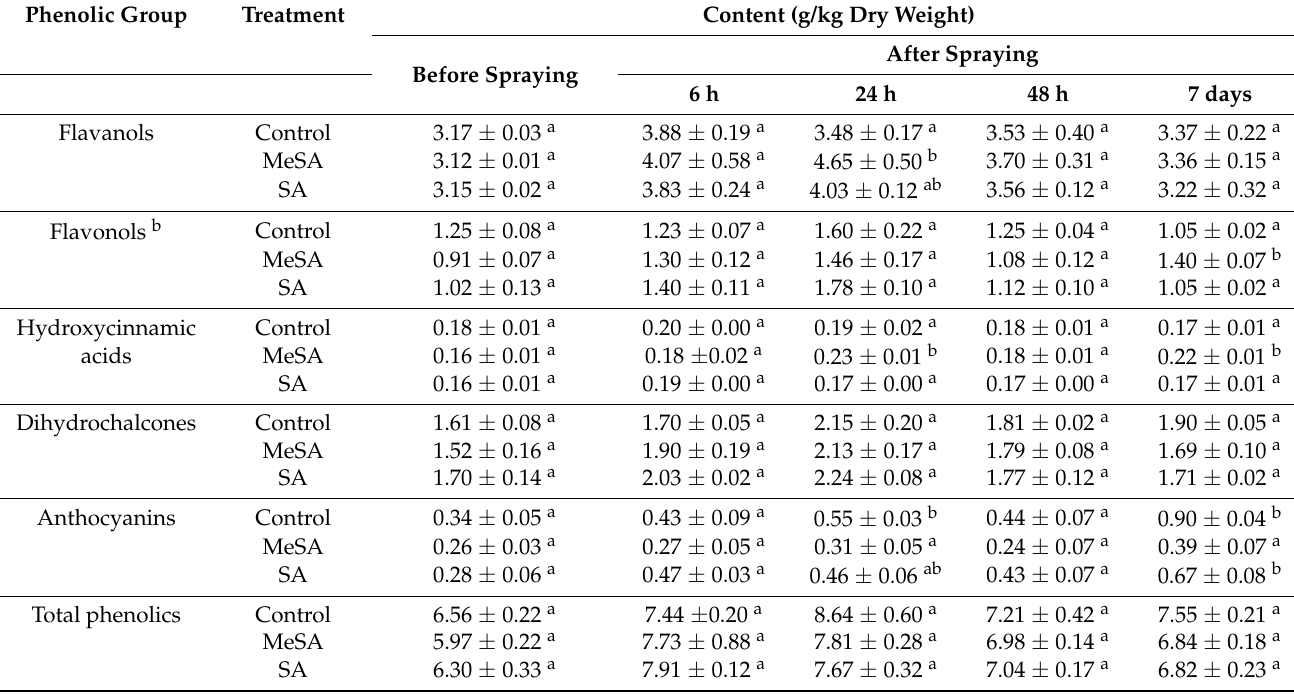
Table 1. Quantification of the major groups of phenolic compounds identified for the Spray#1 control and methyl salicylic acid (MeSA) and salicylic acid (SA) treatments for the apple fruit peel at the different sampling times. See Supplementary Tables S1–S3 for quantification of the individual phenolics analyzed within these groups. Phenolic Group